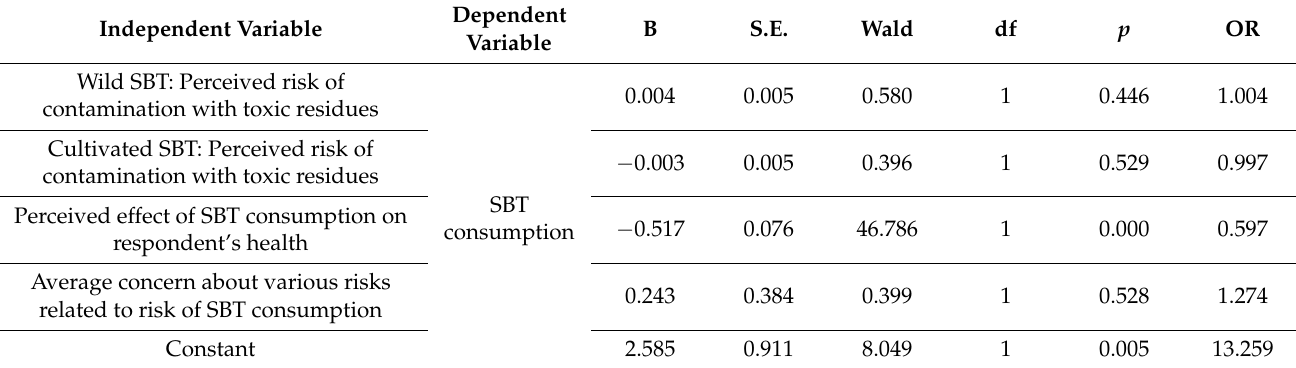
Table 4. Results of binary logistic regression analysis.